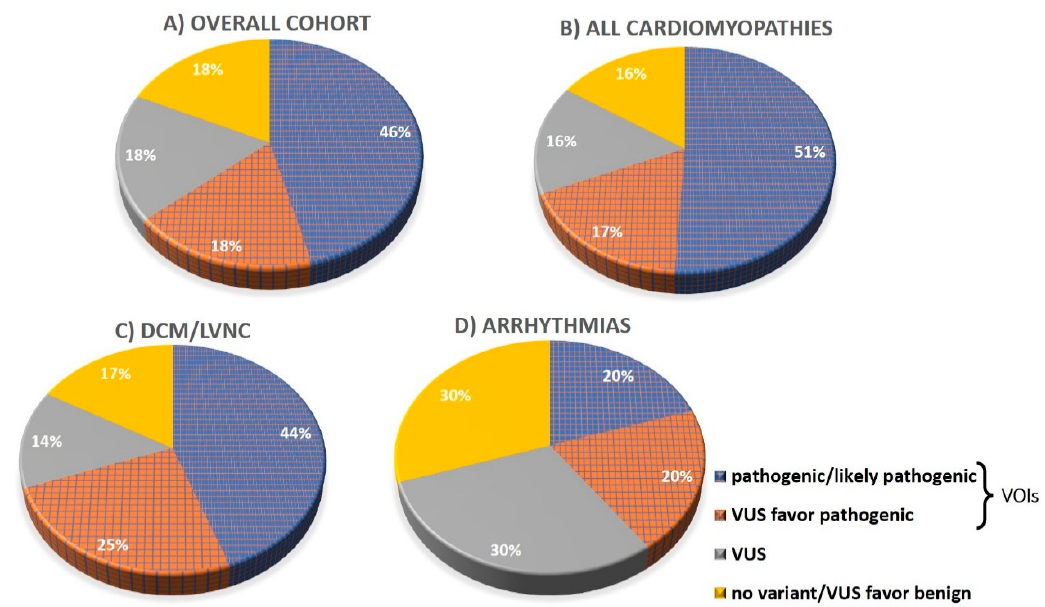
Figure 3. Detection rate of genetic variants in patient cohorts. ( A ) Overall cohort, ( B ) all cardiomyopathies, ( C ) DCM/LVNC, and ( D ) primary arrhythmias.